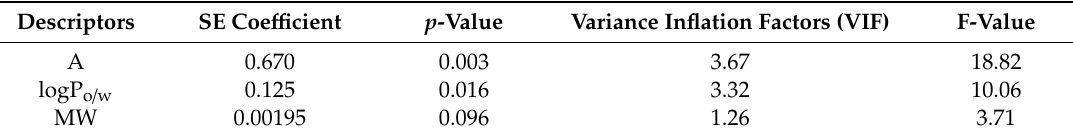
Table 2. Analysis of variance obtained for Equation